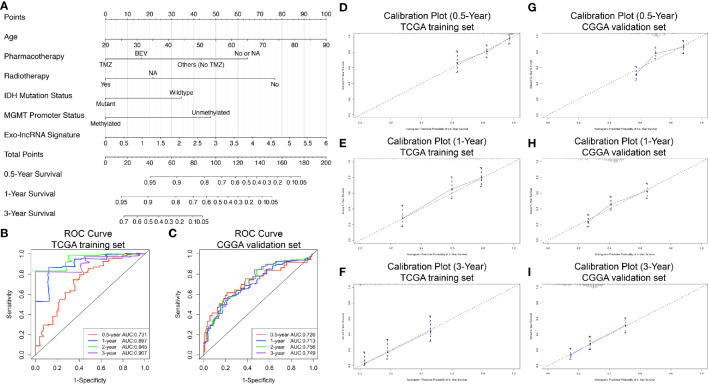
Nomogram to predict the 0.5-, 1-, and 3-year survival probability of patients with GBM. Prognostic nomogram (A) to predict the survival of GBM patients based on the training set from TCGA. Time‐dependent ROC curves based on risk score level in training set from TCGA (B) or in the validation cohort from CGGA (C). Calibration curves of the nomogram for predicting survival at 0.5, 1, and 3 years in the training set from TCGA (D–F) and the validation cohort from CGGA (G–I). The X-axis indicates the nomogram-predicted probability, and the y-axis indicates the actual survival.